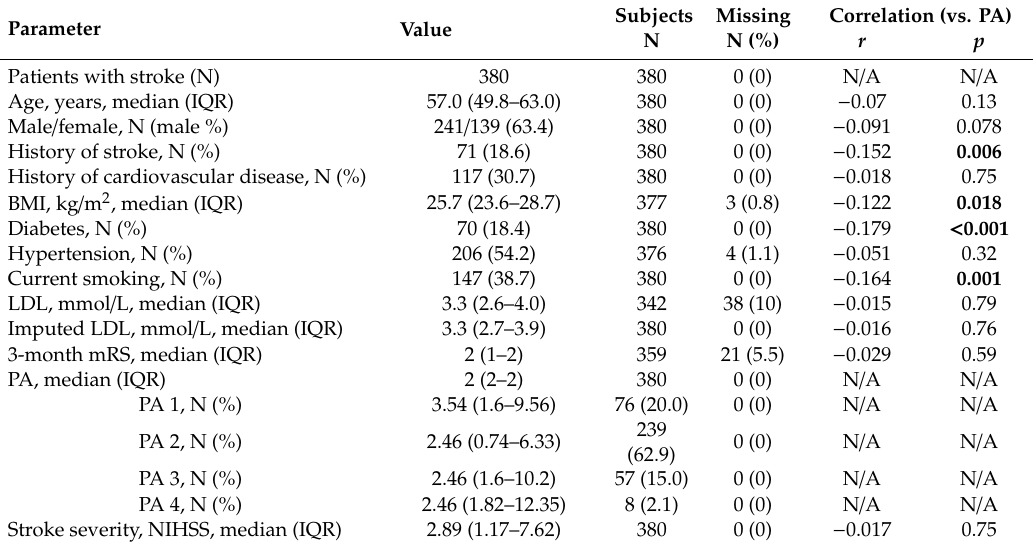
Table 1. Baseline parameters and crude correlations vs. physical activity (PA).